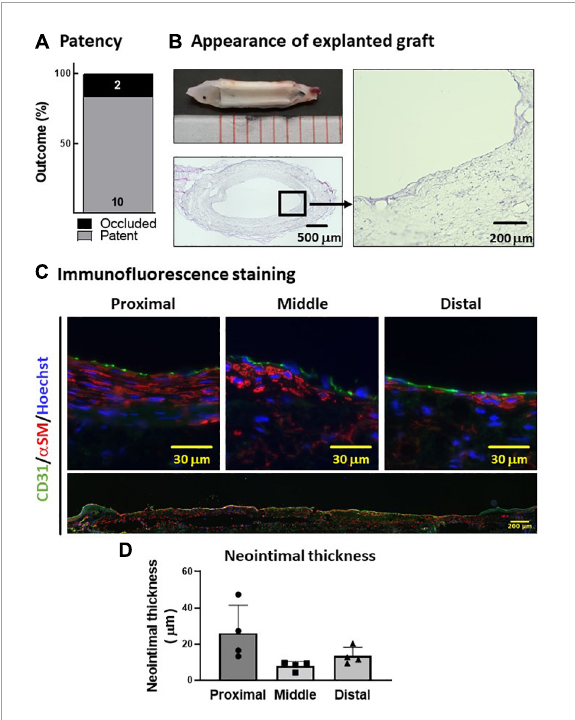
FIGURE4 In vivo evaluation of PVA–PCL graft performance. (A) Patency rate. PVA–PCL grafts were implanted into rat ( n = 12). Patency was determined after 8 weeks. (B) Appearance of explanted graft. Macroscopic appearance (upper left). Cross-sectional HE images: low magnification (lower left) and 400X (right). (C) Neointima images after immunofluorescence staining. Endothelial cell marker CD31 (green) and smooth muscle cell marker α SM (red) were used for immunostaining. The nucleus was counter-stained with Hoechst (blue). All harvested grafts were immunostained, and representative data are shown here. Higher magnification images of a cross-sectional graft are shown at the top, and an end-to-end graft image is shown at the bottom with low magnification. (D) Quantification of the neointimal thickness measured using cross-sectional HE images. The data are expressed as mean ± SD, and the data points represent the individual values in each